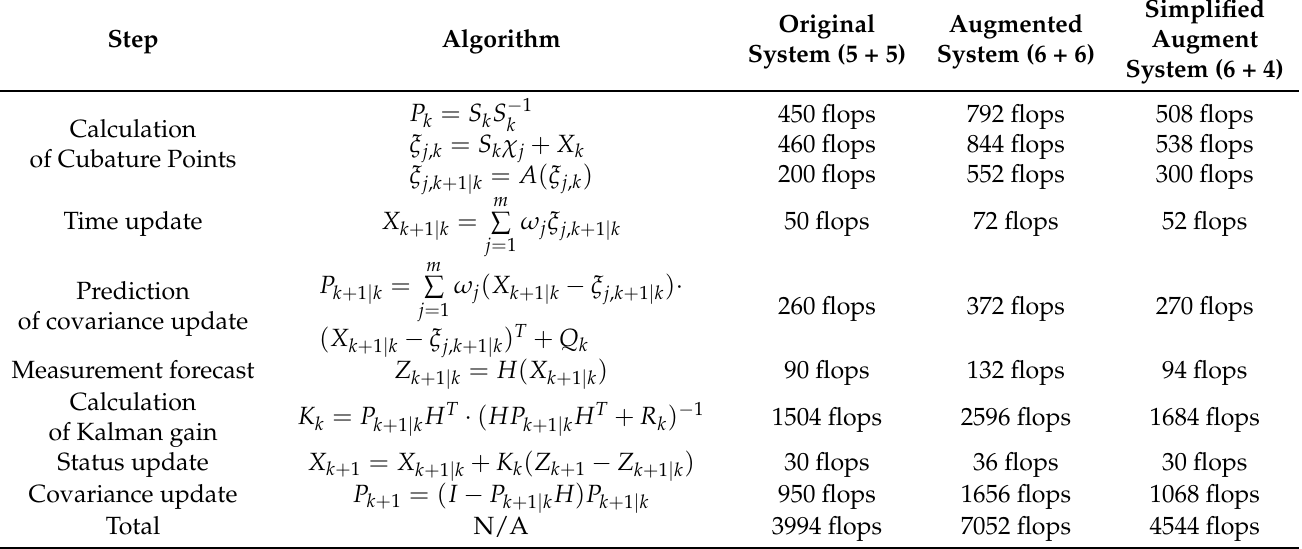
Table 2. Computational complexity analysis of three